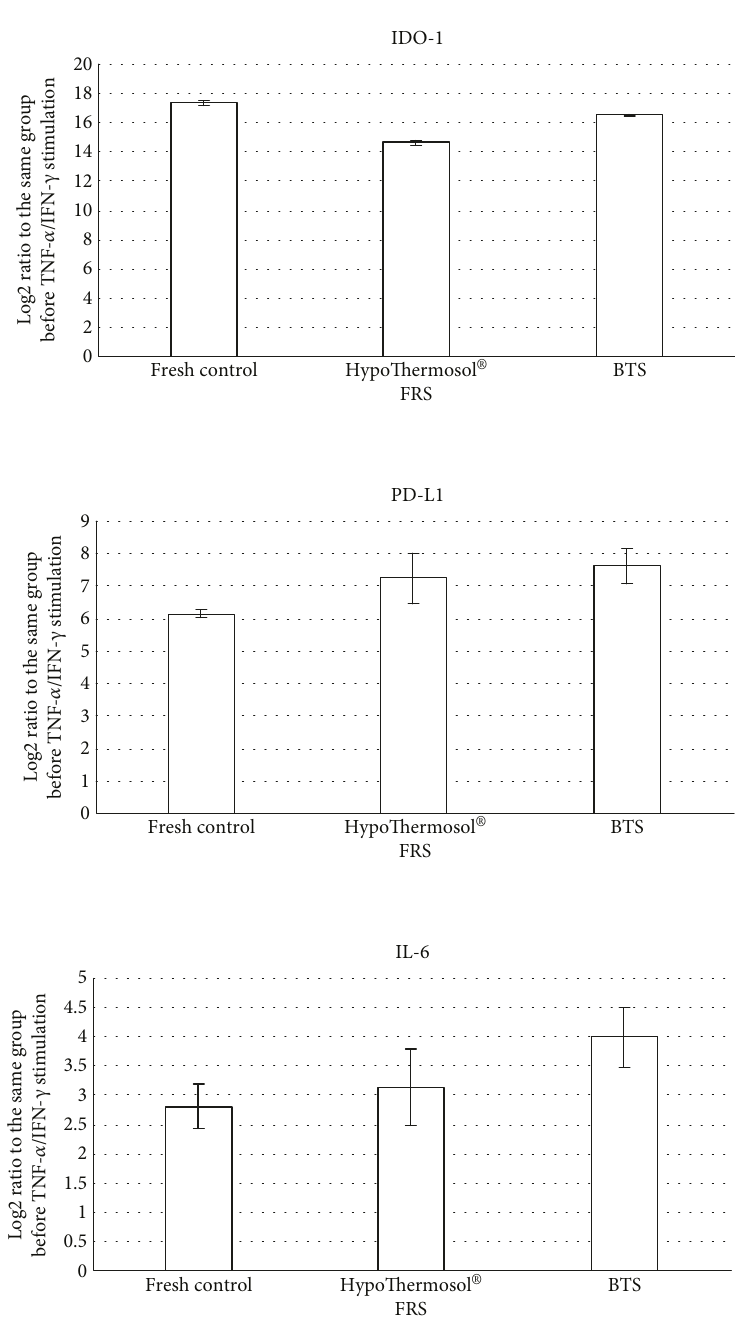
Figure 5: Gene expression analysis of MSCs after 72hrs of hypothermic storage and following TNF- α /IFN- γ